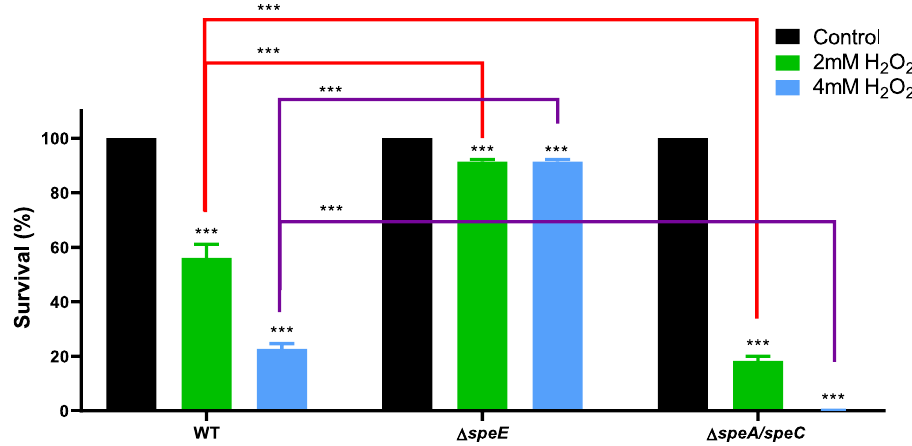
Figure 4. Cell survival in the presence of H 2 O 2 . Cultures of Pst DC3000 and derivative mutant strains in M9 (initial OD 600 = 0.2) were incubated for 1 h under control conditions or in the presence of 2 or 4 mM H 2 O 2 . After this period, CFUs were determined and expressed as a percentage of the values quantified in control cultures (black bars). Statistically significant differences were evaluated by one-way ANOVA followed by Tukey’s multiple comparison tests. Asterisks on top of bars indicate differences between controls and H 2 O 2 -treated cells. Statistical differences between strains are indicated with red and purple square brackets. ***p < 0.001.